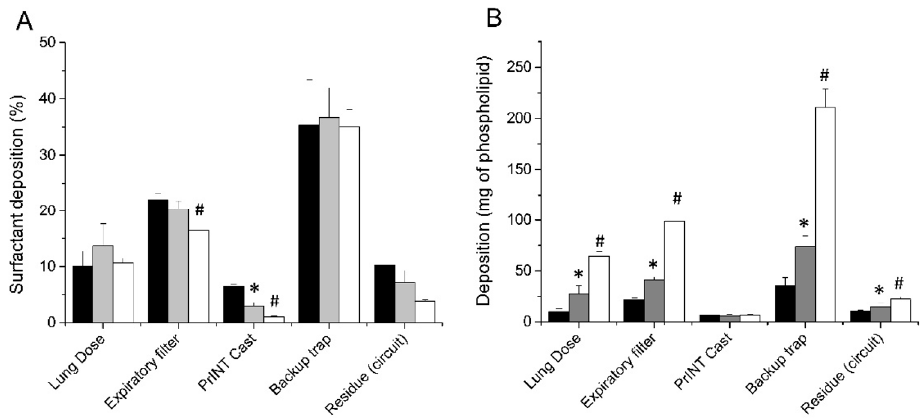
Figure 3. ( A ) Mean cumulative percentage of deposited surfactant within different set-up compartments after delivering surfactant doses of 100 mg/kg (black bars), 200 mg/kg (grey bars), and 600 mg/kg (white bars). ( B ) Mean surfactant mass deposited within the different set-up compartments after delivering surfactant doses of 100 mg/kg (black bars), 200 mg/kg (grey bars), and 600 mg/kg (white bars). * P vs. 100 mg/kg dose < 0.01. # P vs. 200 mg/kg dose < 0.01.